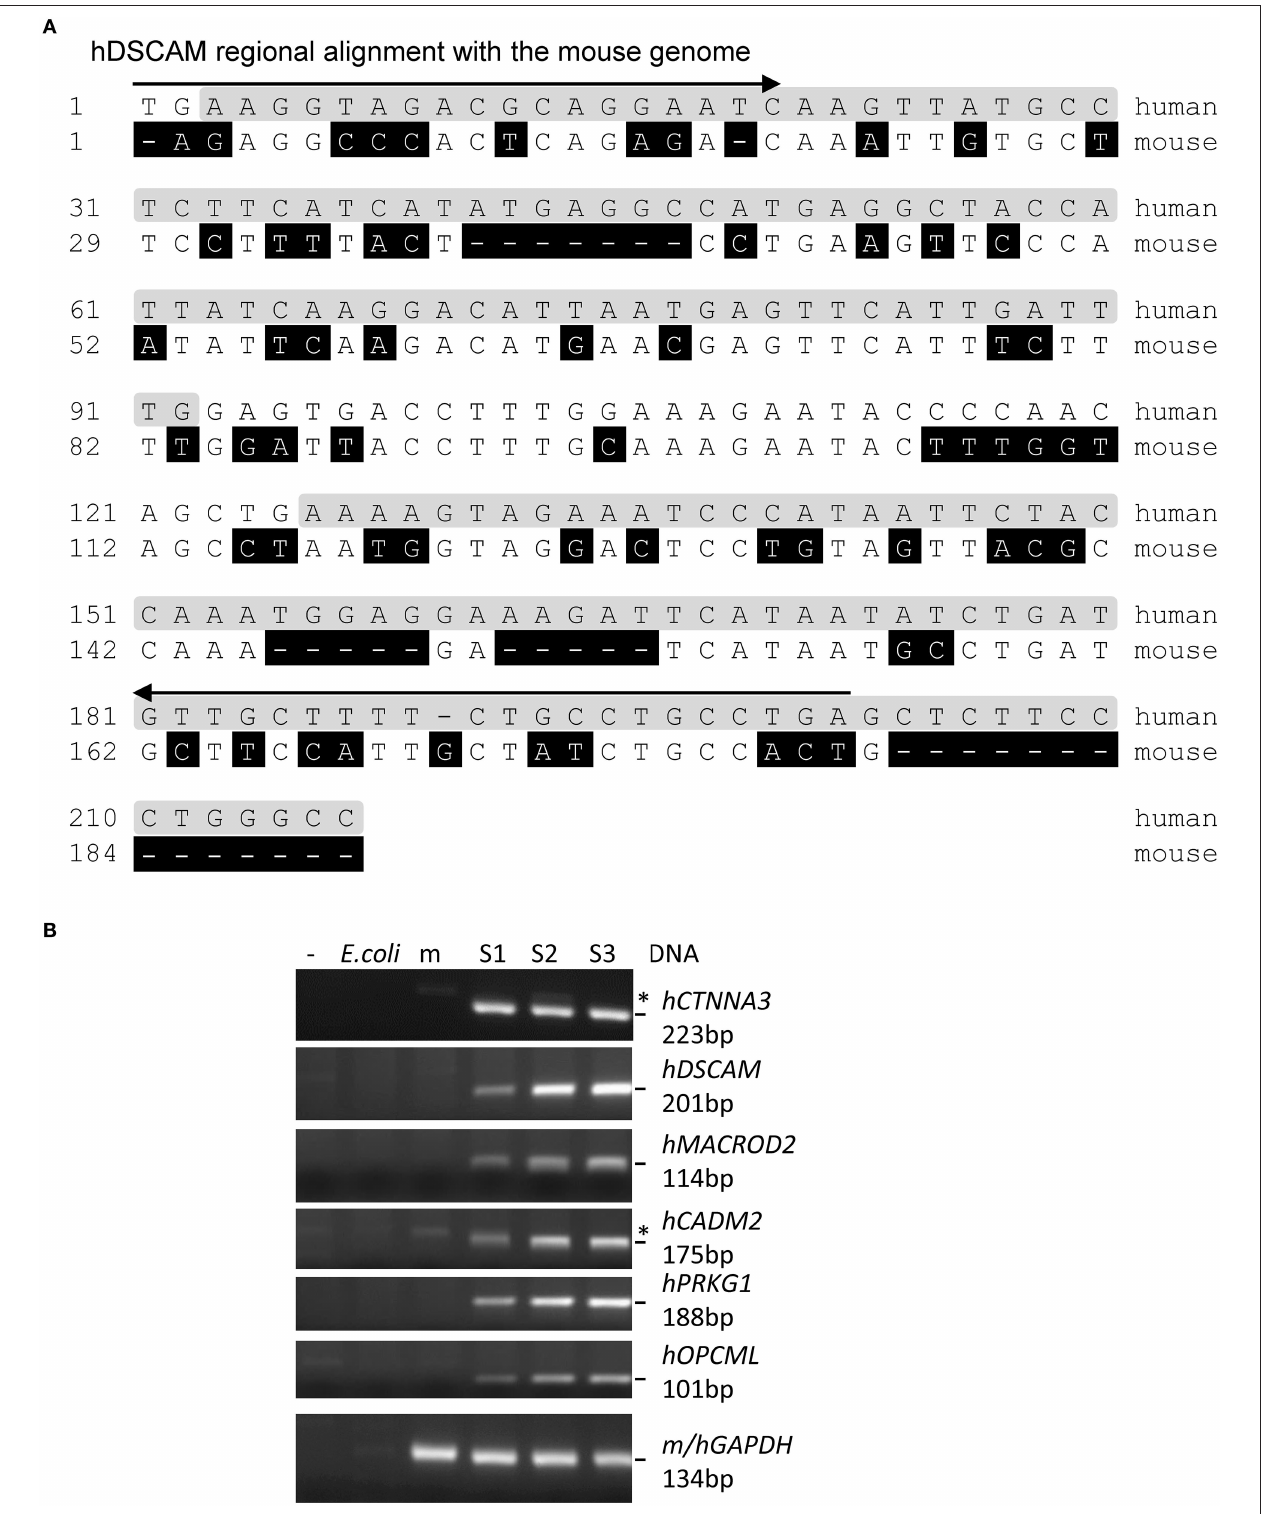
FIGURE 2 | Examples of human-specific sequences of the WGBS reads. (A) Human-specific reads of a gene identified through WGBS of the xenografted mouse cfDNA. Arrow: PCR primer; shaded in gray: reads sequence identified by BSMAP; shaded in black: mismatch from human sequences. (B) Agarose gels of the PCR products of six successfully amplified genes from the S1–S3 tumors using human-specific primers (the S4 tumor DNA was accidentally lost during preparation). *:non-specific bands also present in the PCR negative control or mouse lanes. m: mouse; h: human. The GAPDH primers bind both mouse and human GAPDH .